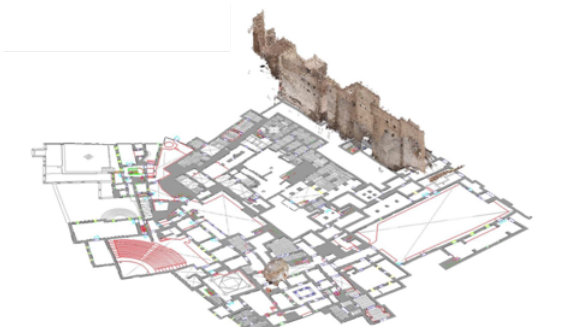
Figure 7: 3D point cloud from photogrammetry used for the preparation of accurate line drawings of the Kasbah of Taourirt, The Getty Conservation Institute and Carleton Immersive Media